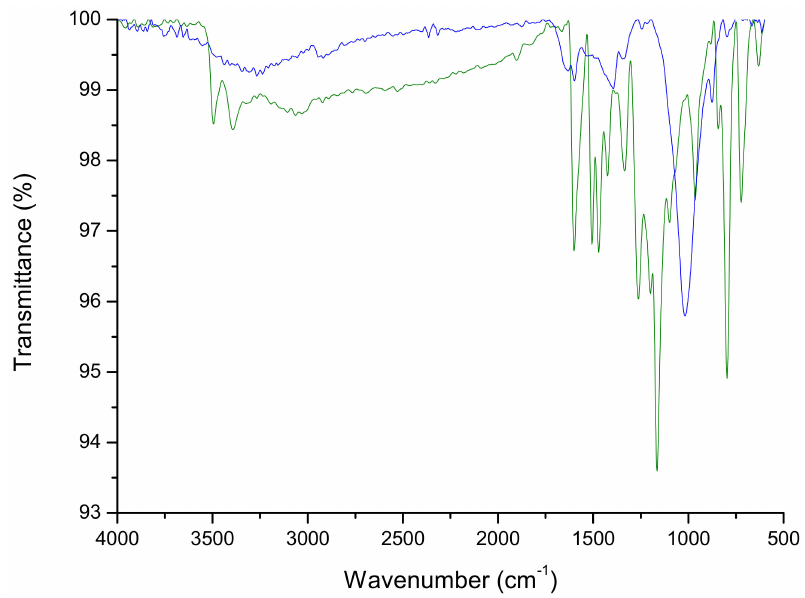
Figure 3. FTIR spectra of the obtained biomass (green line) and biomass/dye (blue line).